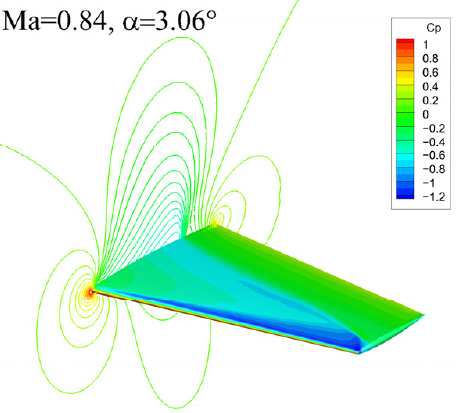
Figure 15. Contours of pressure coefficient ( Ma = 0.84, α = 3.06 ◦ ) .